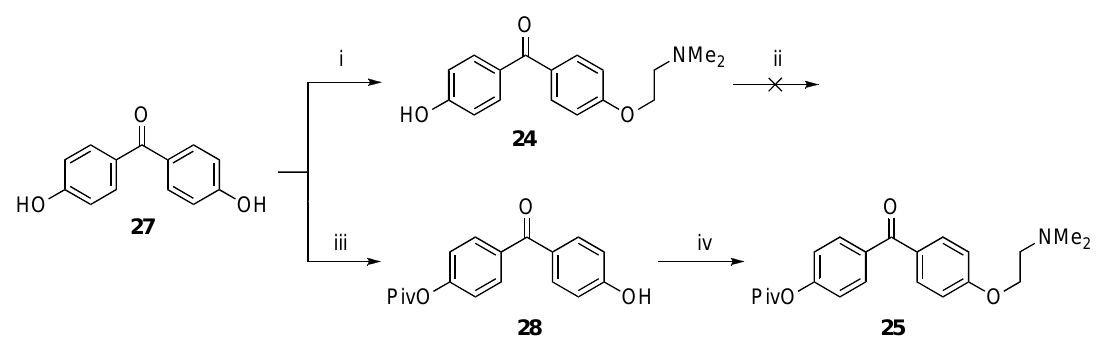
Figure 1. Displacement ellipsoid plot of 13 , drawn at the 50% probability level. Hydrogen atoms and disordered solvent molecules are omitted for clarity. The halogen position is occupied by 60% chlorine and 40% bromine; only chlorine derivative is shown. Symmetry operation i: −x, y,